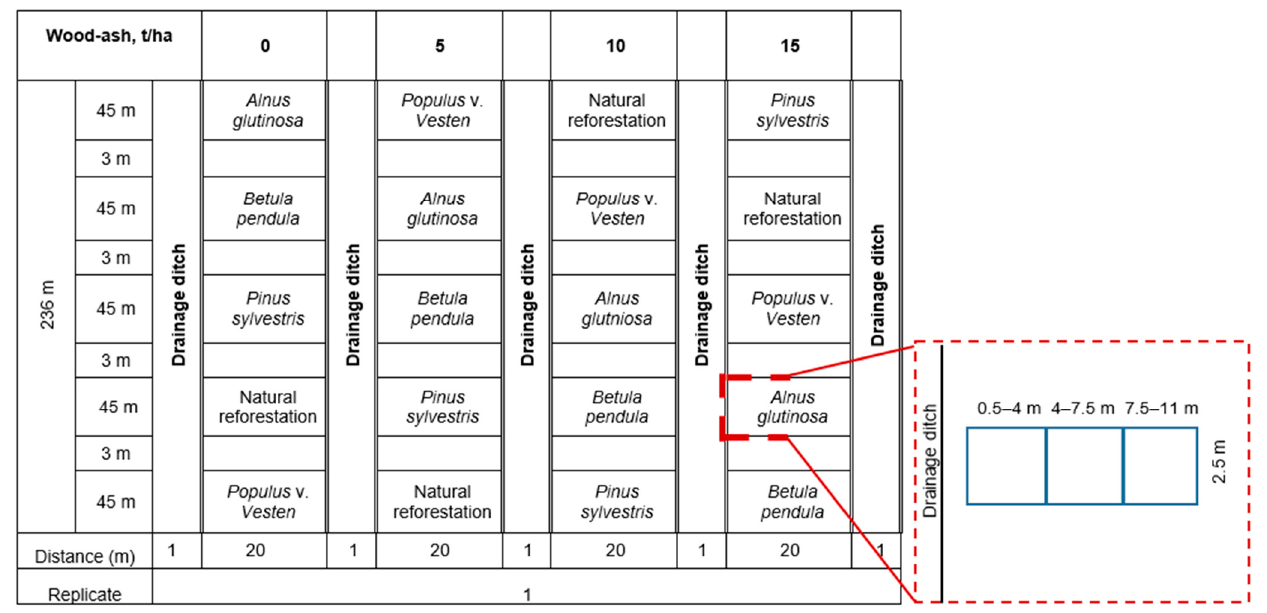
Figure 2. Plan of one repetition in research